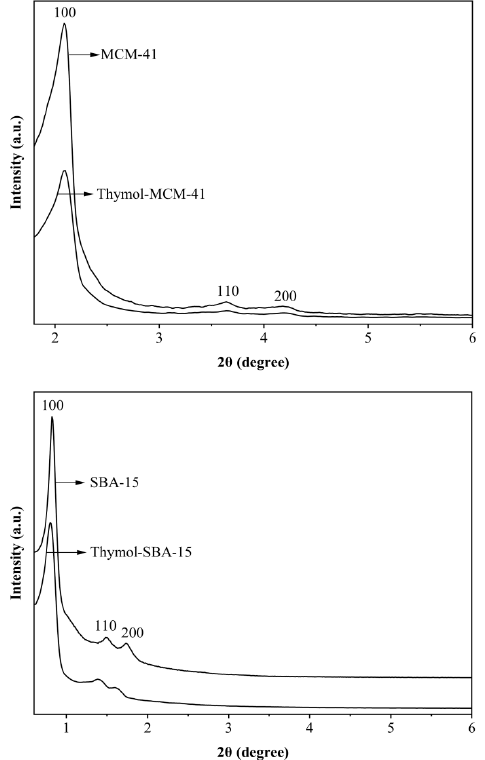
Figure 6. Small-angle XRD of MCM-41, SBA-15, Thy-MCM-41, and Thy-SBA-15.